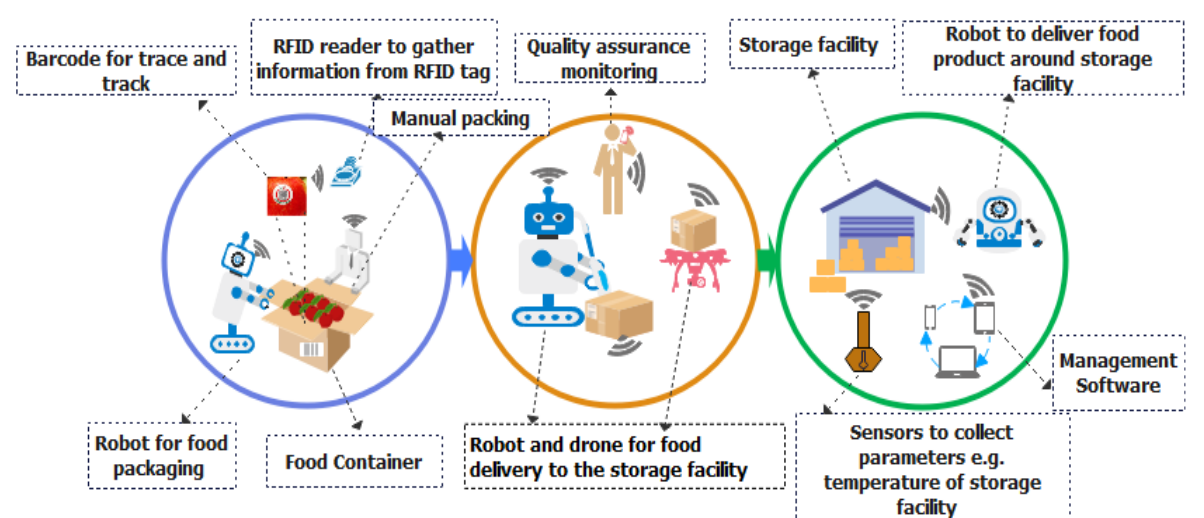
Figure 5. Postharvest operations and food processing.